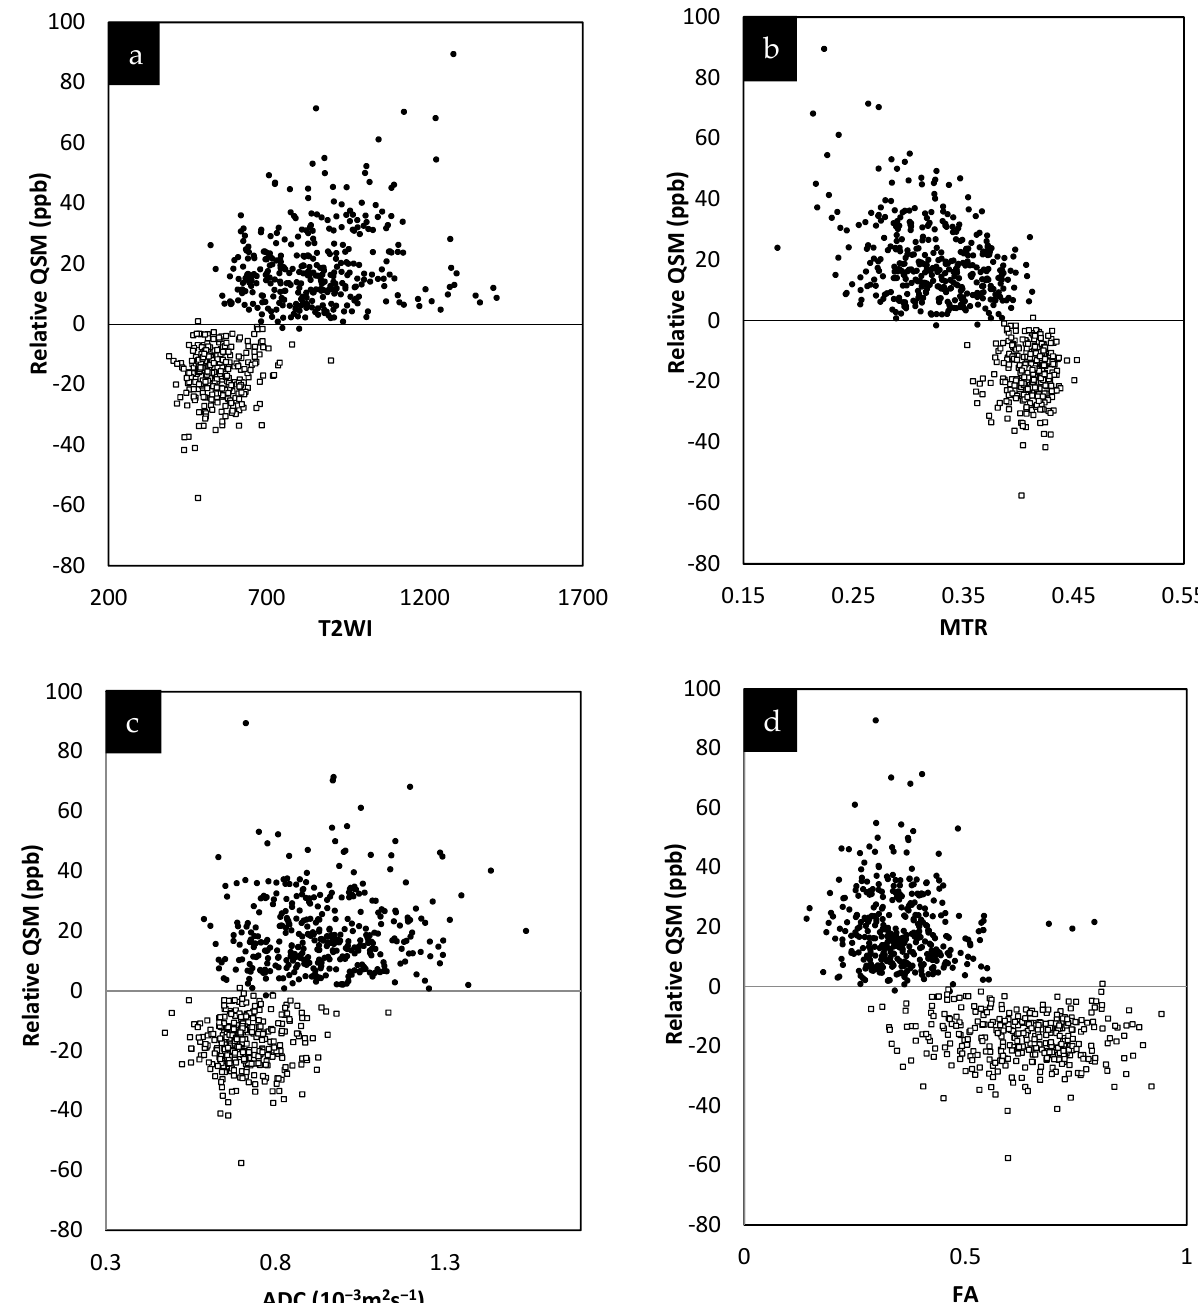
Figure 4. Relative susceptibility in parts per billion (ppb) for QSM versus MTR averaged across the two different time points ( a ). Relative susceptibility for QSM versus T2WI averaged across the two different time points ( b ). Relative susceptibility for QSM versus ADC averaged across the two different time points ( c ). Relative susceptibility for QSM versus FA averaged across the two different time points ( d ). In all these plots, the results for the MS lesion (solid black circles) values are well separated from the normal tissue values (square sign).